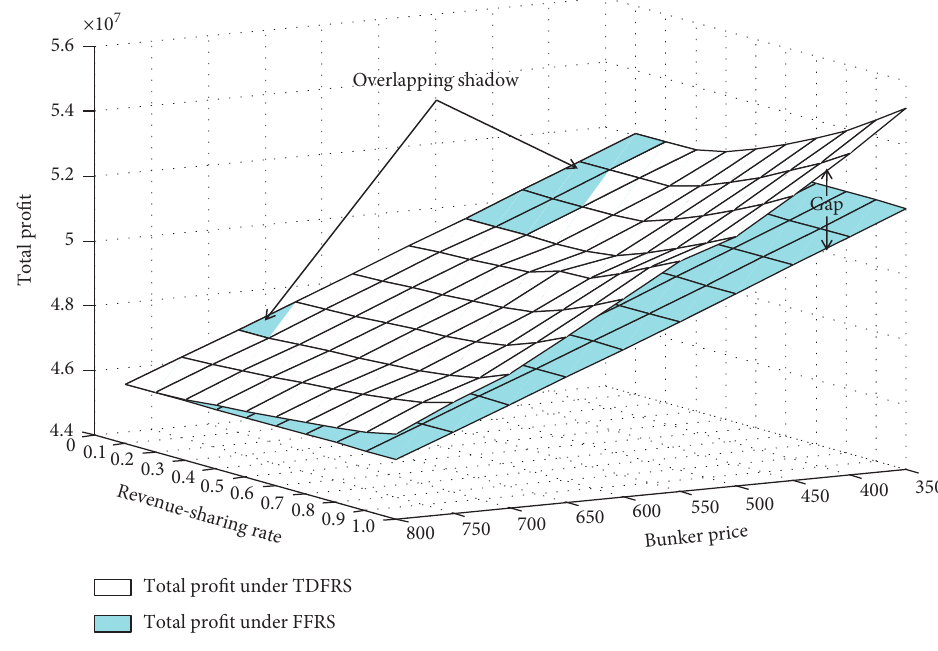
Figure 3: Changes of the total profit under the two freight rate